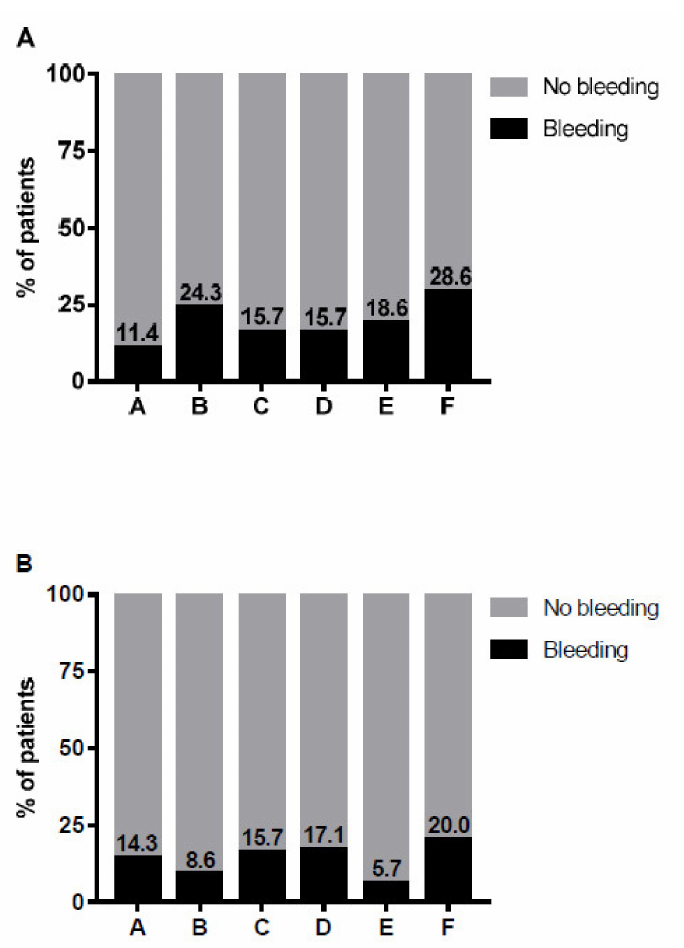
Figure 2. Proportion of patients with traumatic ( A ) and spontaneous ( B ) bleeding during emicizumab therapy. The proportions of bleeding patients at different “bleeding periods” of the study were compared using the Cochran’s Q test. No statistically significant difference in the proportions of patients with either traumatic or spontaneous bleeding episodes during emicizumab therapy was revealed ( P = 0.053 and P = 0.092, respectively). “Bleeding periods”: A—loading, B—1–3 months, C—3–6 months, D–6–9 months, E—9–12 months, F—12–18 months. Black—% of patients with bleeding, gray bars—% of patients with no